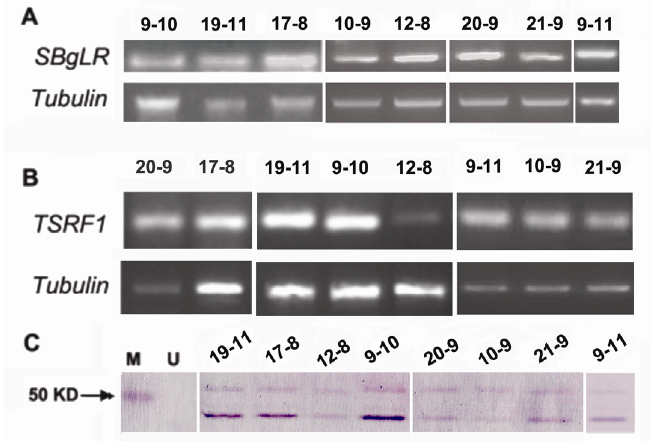
maize (partial results are shown). Figure 2. Expression of transgenes in T 1 ( A ) Semi-quantification RT-PCR analysis of SBgLR in transgenic maize immature seeds (22 DAP); ( B ) semi-quantification RT-PCR analysis of TSRF1 in transgenic maize leaves; ( C ) Western blot analysis of SBgLR in transgenic maize immature seeds (20 DAP). M, protein marker; U, non-transformed maize plants. Numbers on the top of each figure represent the transgenic line